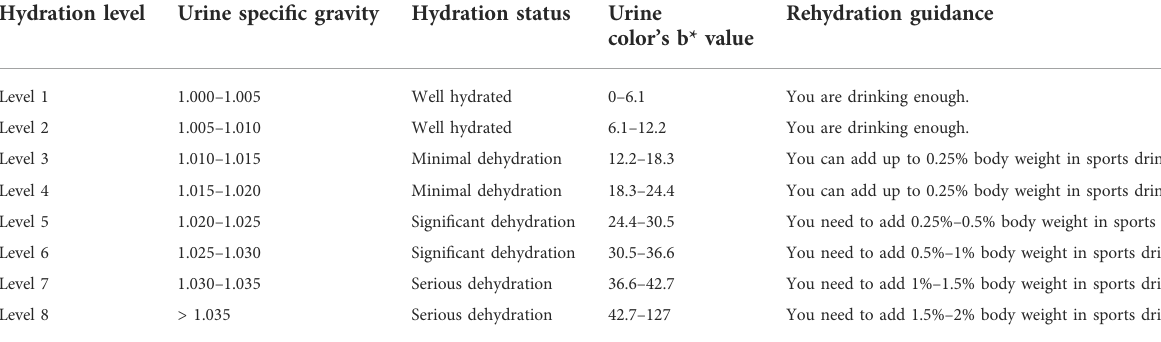
TABLE 1 System hydration grading